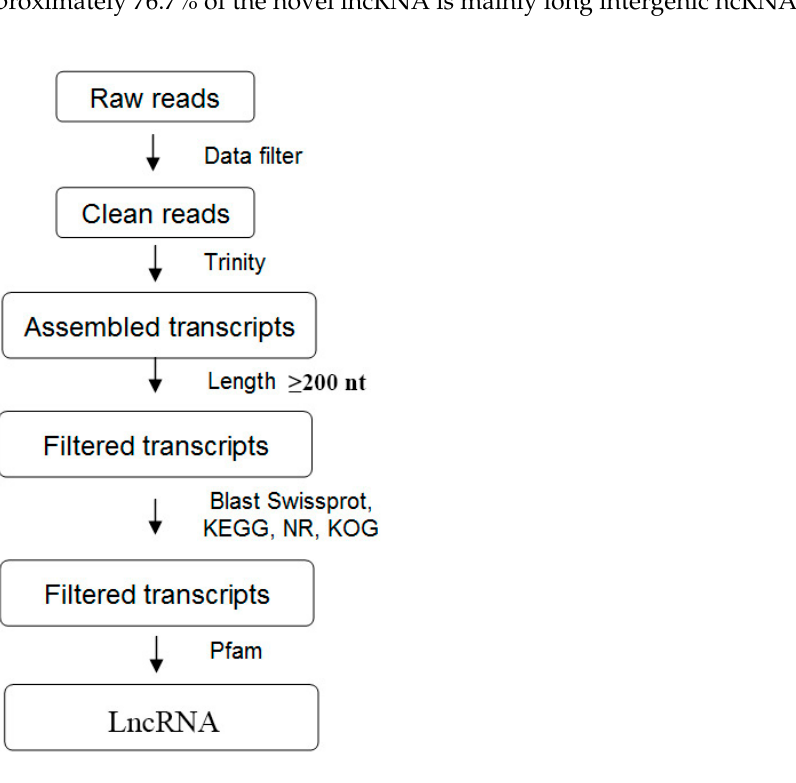
Figure 2. Characteristics of mRNA and lncRNA in Nicotiana benthamiana . ( A ), ( B ), and ( C ) Num ber of different lengths of lncRNAs and mRNAs in these transcripts, Exon numbers and open reading frame length density characteristics in the identified lncRNAs and mRNAs; ( D ) differ ‐ ent types of lncRNAs were identified in the leaf of N. benthamiana , including intergenic lncRNAs, antisense lncRNAs (lncRNAs with exonic overlap with a known transcript),